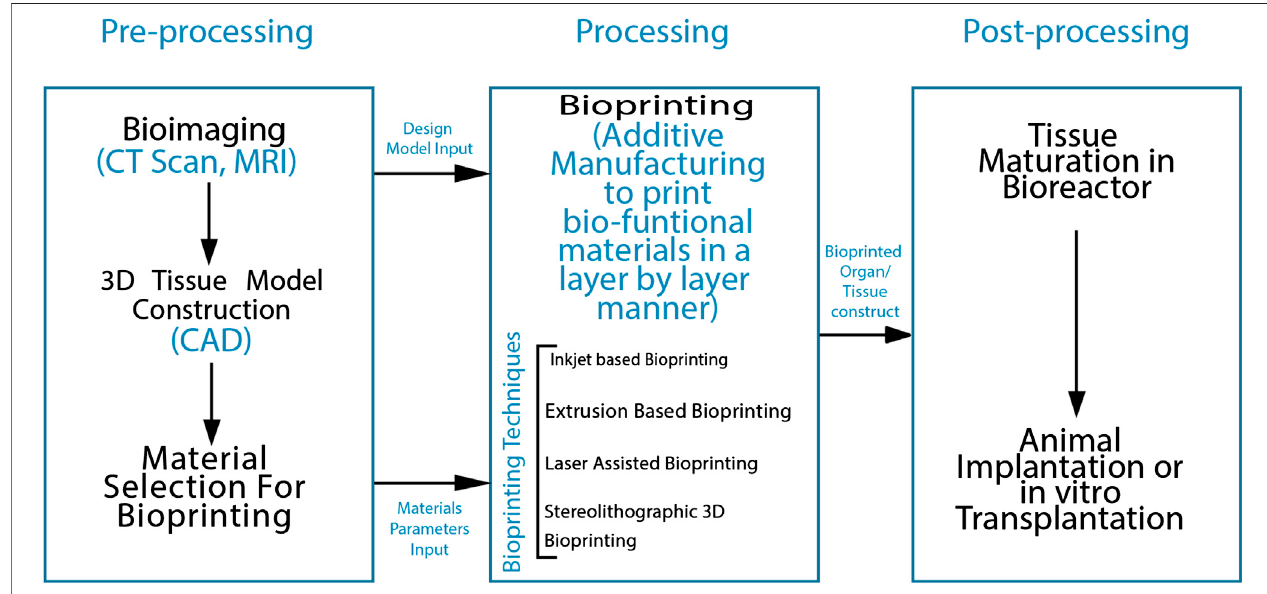
FIGURE 1 | Flow-diagram for process of 3D